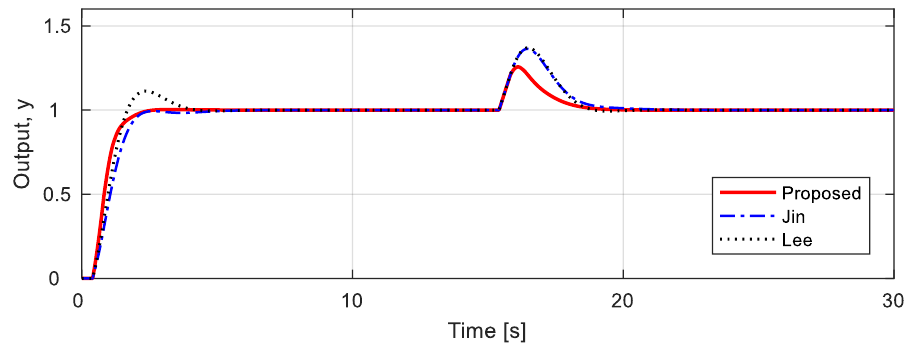
Figure 4. Unit step responses for nominal process 𝑃 1 . Table 2. Performance comparisons for nominal process 𝑃 1 . Table 2. Performance comparisons for nominal process P